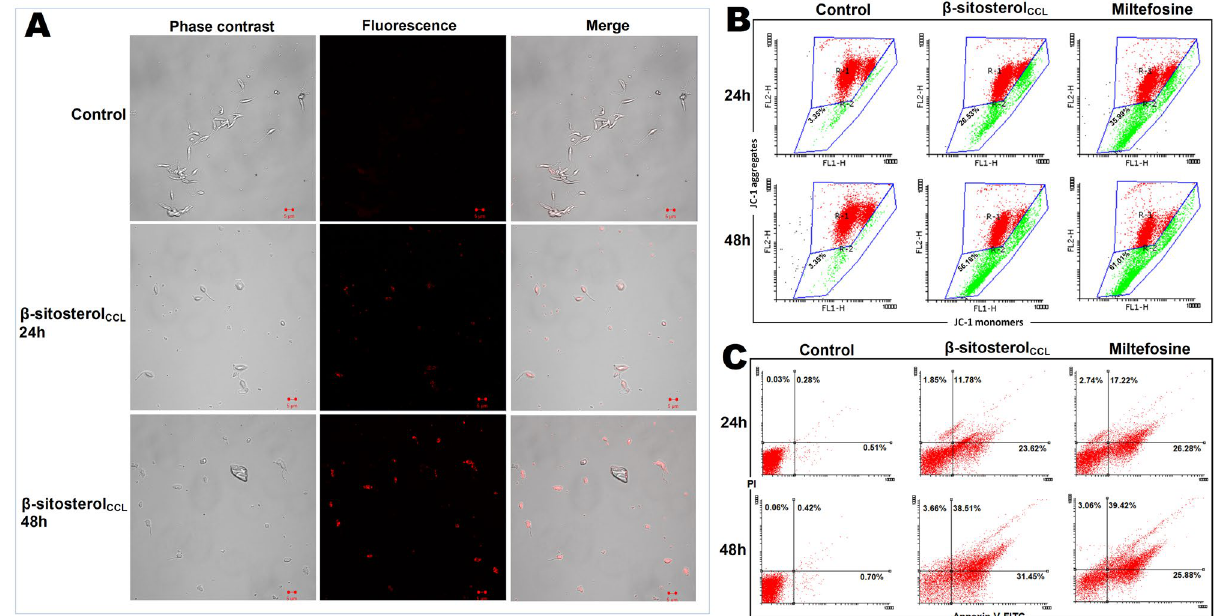
Figure 6. ( A ) Superfluous lipid body detection in L. donovani promastigotes. Promastigotes (1 × 10 7 /ml) treated with β-sitosterol CCL for 24 h and 48 h; images were obtained by LSM510-META confocal microscopy after Nile Red staining. Phase contrast, fluorescence, and phase contrast-fluorescence merged images are representative of three independent experiments. ( B ) Flow cytometric determination of mitochondrial membrane depolarization. Promastigotes (1 × 10 7 /ml) treated with β-sitosterol CCL (IC 50 dose) for 24 h and 48 h followed by JC-1 staining. The fluorescence intensity of JC-1 was measured, and histograms (snapshot) of β-sitosterol CCL -treated parasites were compared with control and miltefosine (10 µM)-treated cells for 24 h and 48 h. Red (R-1 region) and green (R-2 region) depict high and low mitochondrial membrane potential, respectively. The snapshots are representative of one of three independent experiments. Data were acquired in a BD FACSCalibur